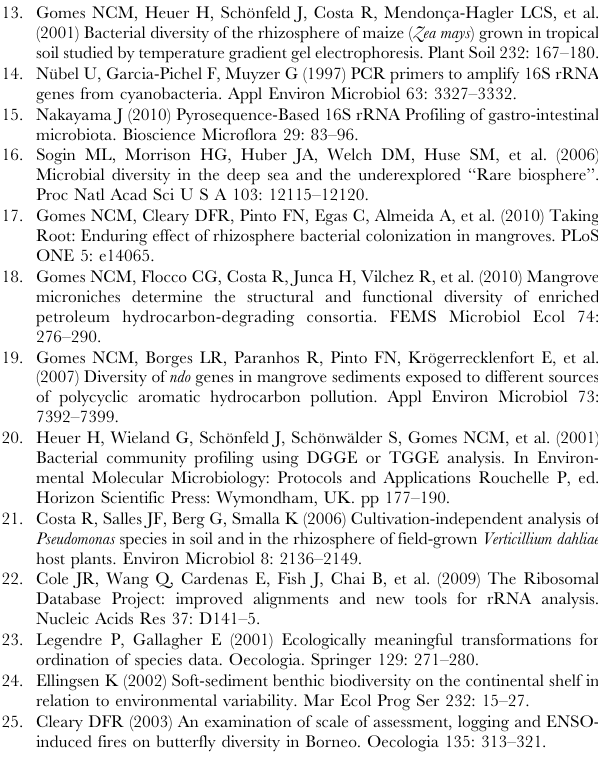
Figure S1 Denaturing gradient gel electrophoresis (DGGE) fingerprints of 16S ribosomal RNA gene fragments amplified from rhizospheres of nursery (Nur), transplanted (Trn), native R. mangle (Nat) and bulk sediment (Sed). All bacteria (a); Alphaproteobacteria (b); Betaproteobacteria (c). (M) Bacterial marker. Figure S2 Principal coordinate (PCO) analysis. The first two axes of a PCO ordination are shown based on a matrix of OTU